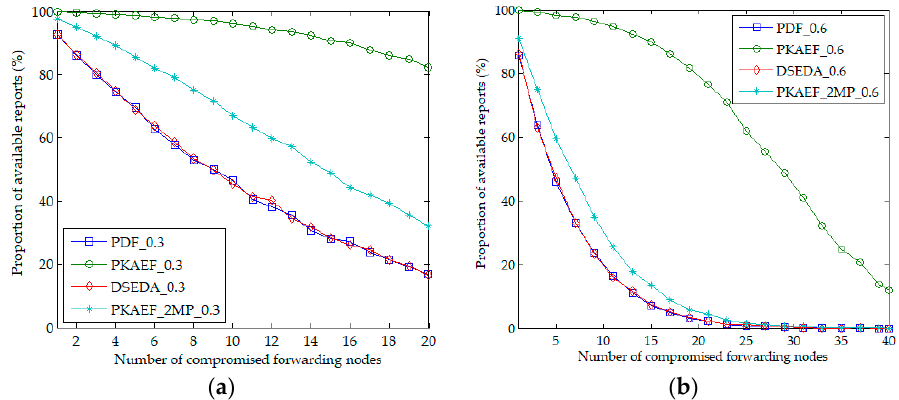
Figure 6. Proportion of available reports as a function of the number of compromised forwarding nodes. ( a ) in Scenario 1; ( b ) in Scenario 2.